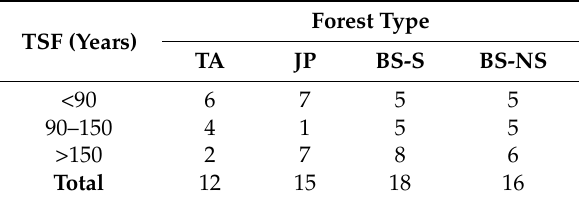
Table 1. Distribution of study sites in different successional stages and forest types. Forest Type TSF (Years) TA JP BS-S